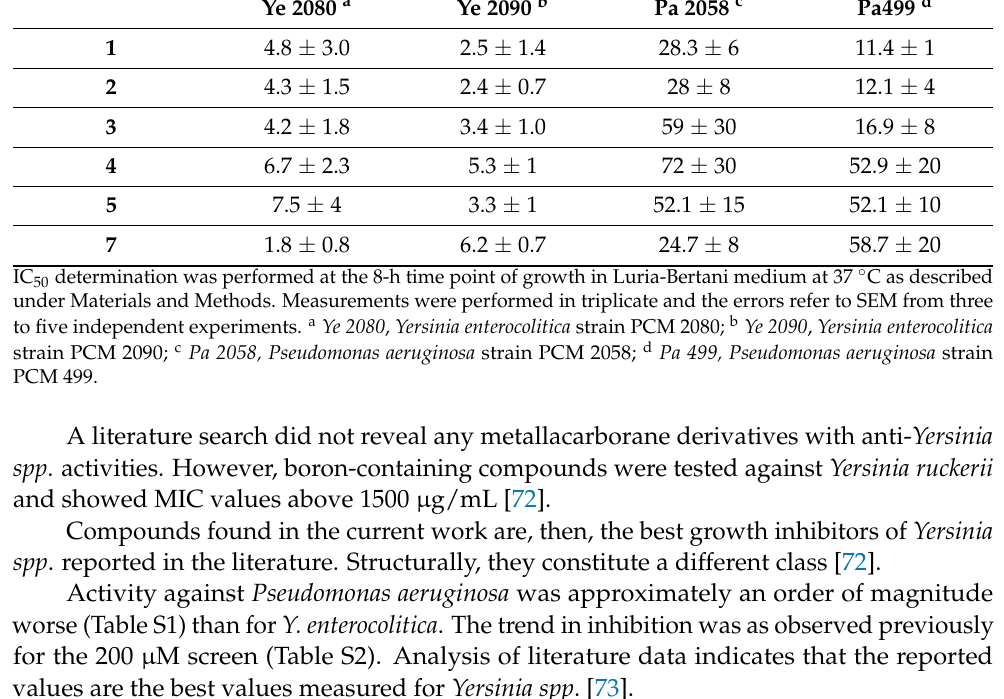
Table 1. Top hits IC 50 values for growth inhibition of selected pathogens. Compound No.